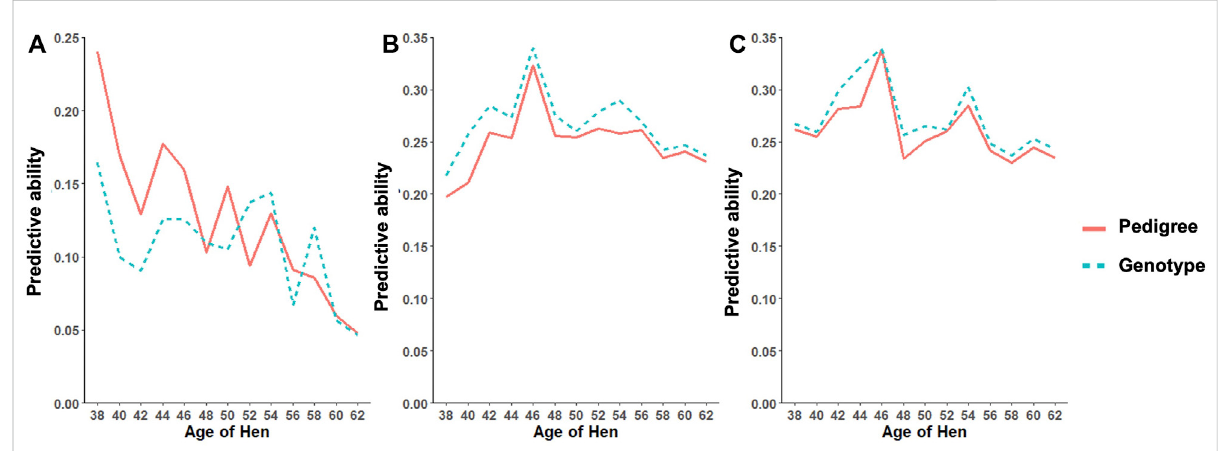
FIGURE 4 Predictive ability trend for different age classes for (A) fertility (FERT), (B) hatch of fertile (HOF), and (C) hatch of set (HOS) estimated from the random regression model using pedigree and genotypic